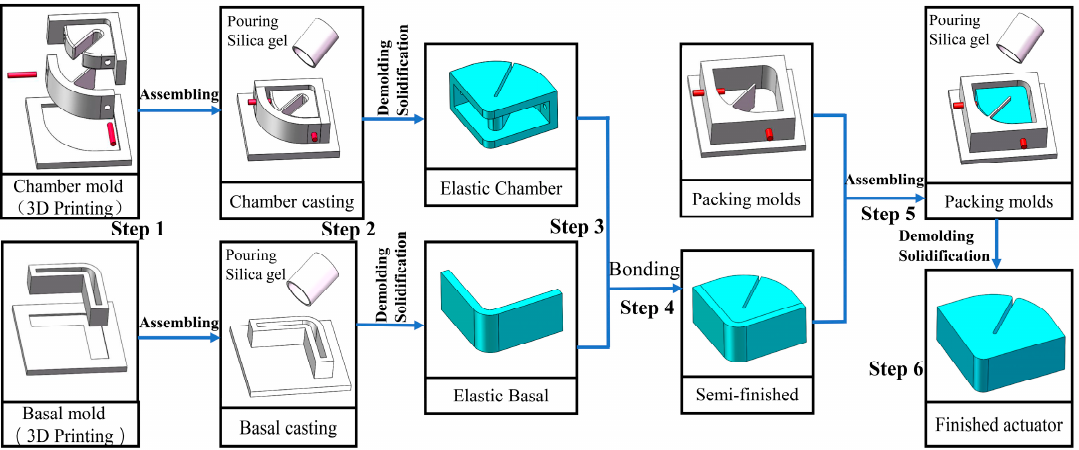
Figure 4. Fabrication progress of the flexible joint.